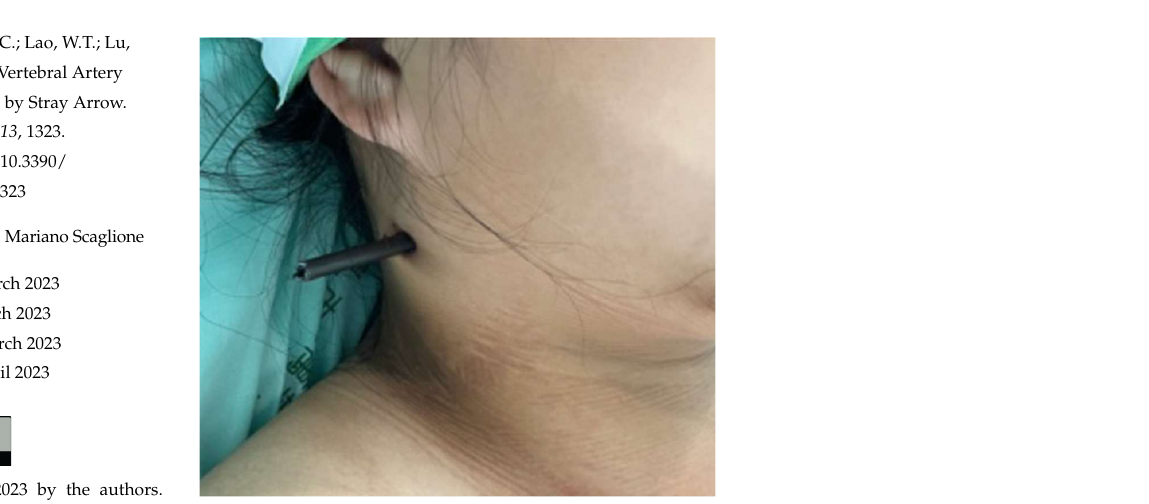
Figure 1. Penetrating trauma with arrow at the right side of the patient’s neck (tail end of the arrow cut and